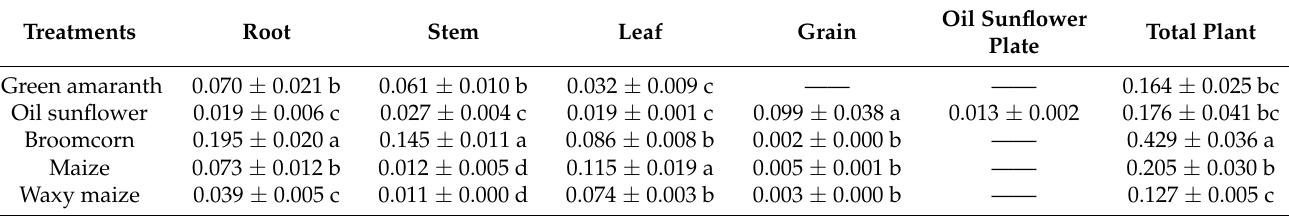
Table 5. Cd accumulation in each part of different plants (mg · pot − 1